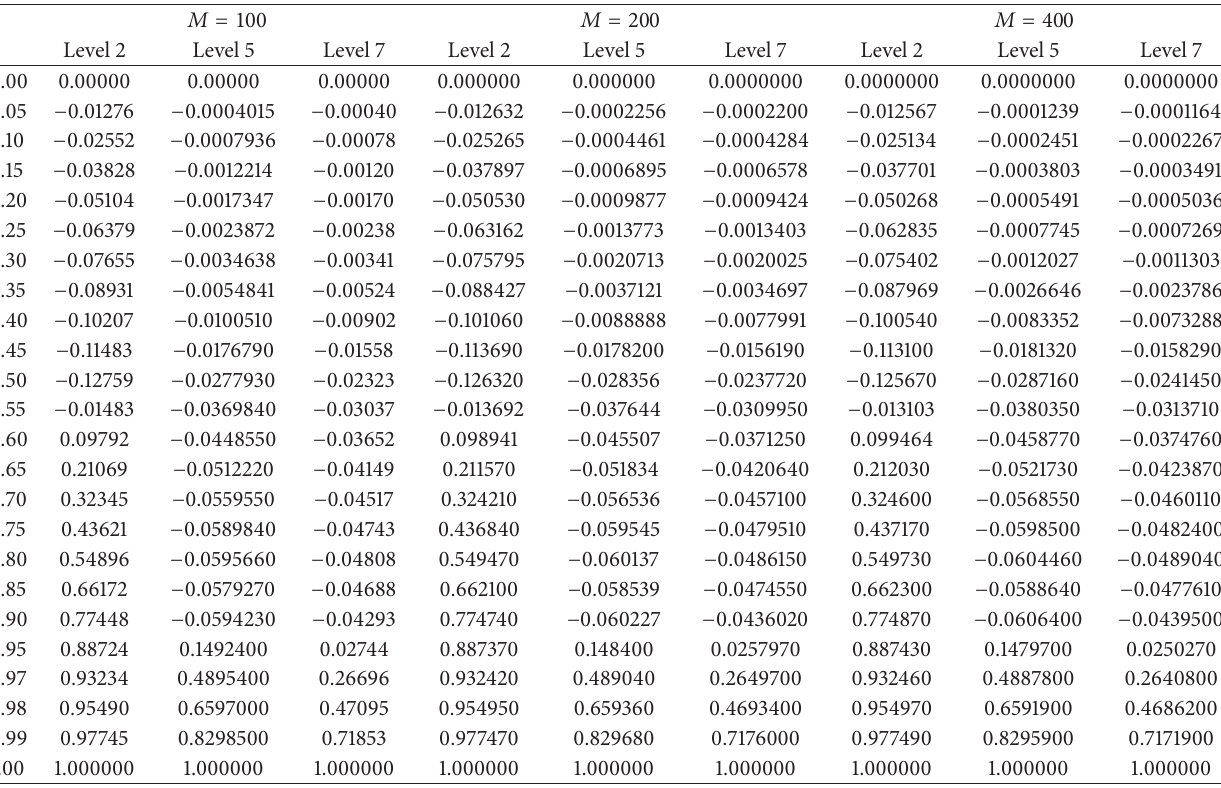
Table 5: Values of the 𝑥 -component of the velocity along the vertical center line for Bn = 100